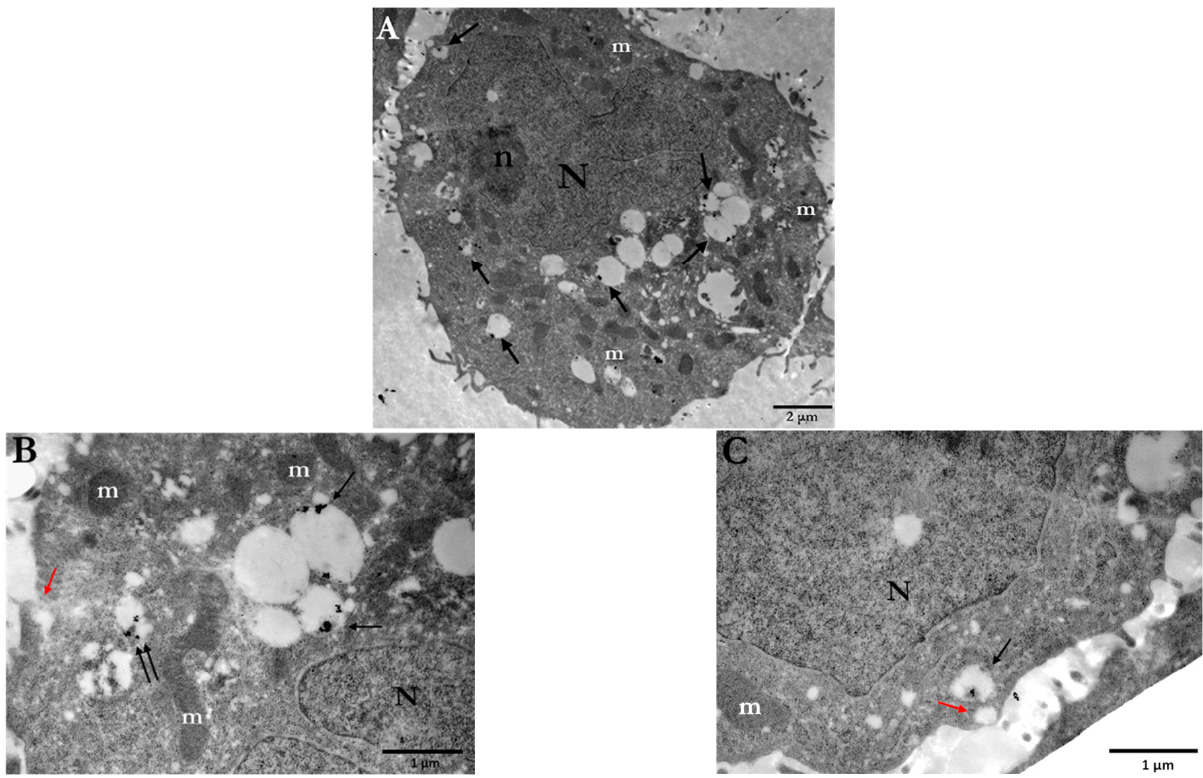
Figure 1. Electron micrographs of PC3 cells indicating the cellular uptake of 15 nm Ct-AuNPs (10 µ g/mL) after 24 h. ( A ) Arrows point to the different areas of the cytoplasm, where nanoparticles are located inside vesicles or autophagosomes. ( B , C ) Higher magnification of ( A ). Ct-AuNPs are located inside vesicles (single arrows) and autophagosomes (double arrows). Red arrows indicate vesicular formations of the plasma membrane by which NPs may be endocytosed or excreted by the cell. Scale bars: ( A ) 2 µ m; ( B ) and ( C ) 1 µ m. N: nucleus, n: nucleolus, m: